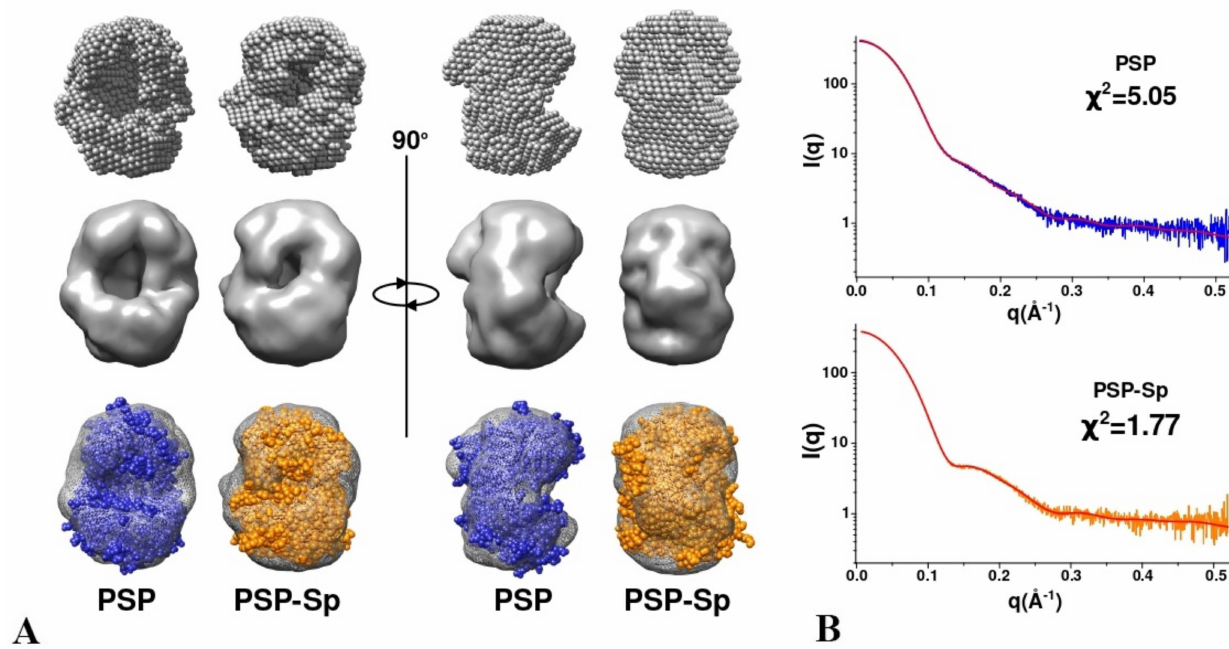
Figure 6. Ab initio shape reconstruction for PSP and PSP-Sp using DAMMIN. ( A ) Bead models, density maps with 12 Å resolution and full-atom models of open PSP state (blue) and 7OB1 (orange) fitted in them; ( B ) comparison of the experimental SAXS profiles of PSP and PSP-Sp with the corresponding theoretical profiles of DAMMIN ab initio models (red